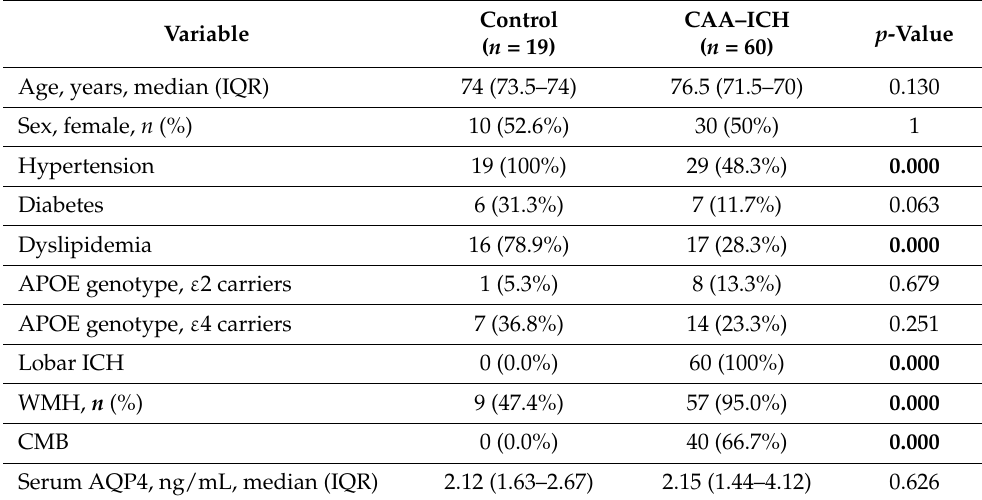
Table 1. Demographic, clinical, and radiological characteristics of the total